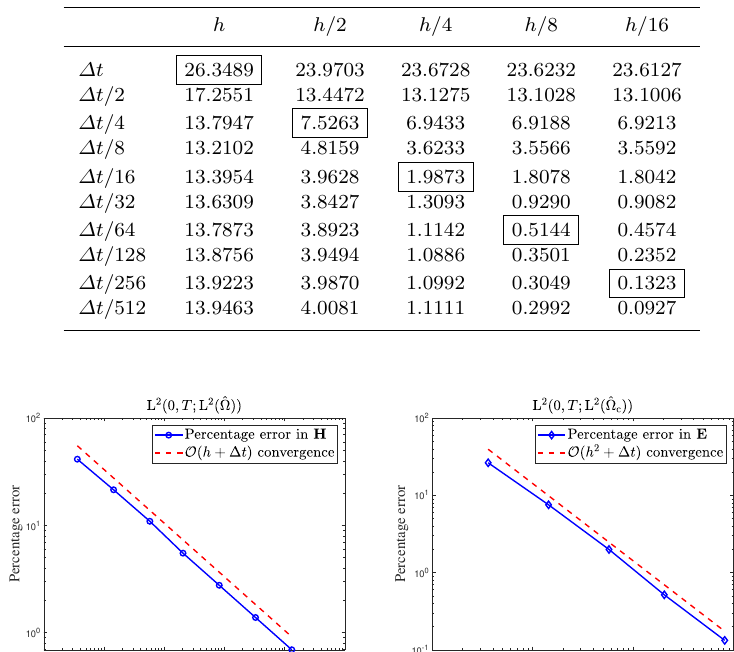
))-norm, with h = 0 . 3687 and C